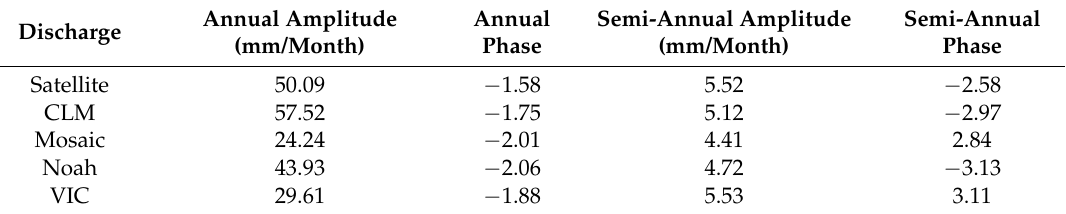
Table 7. Seasonal amplitudes and phases of satellite- and model-based